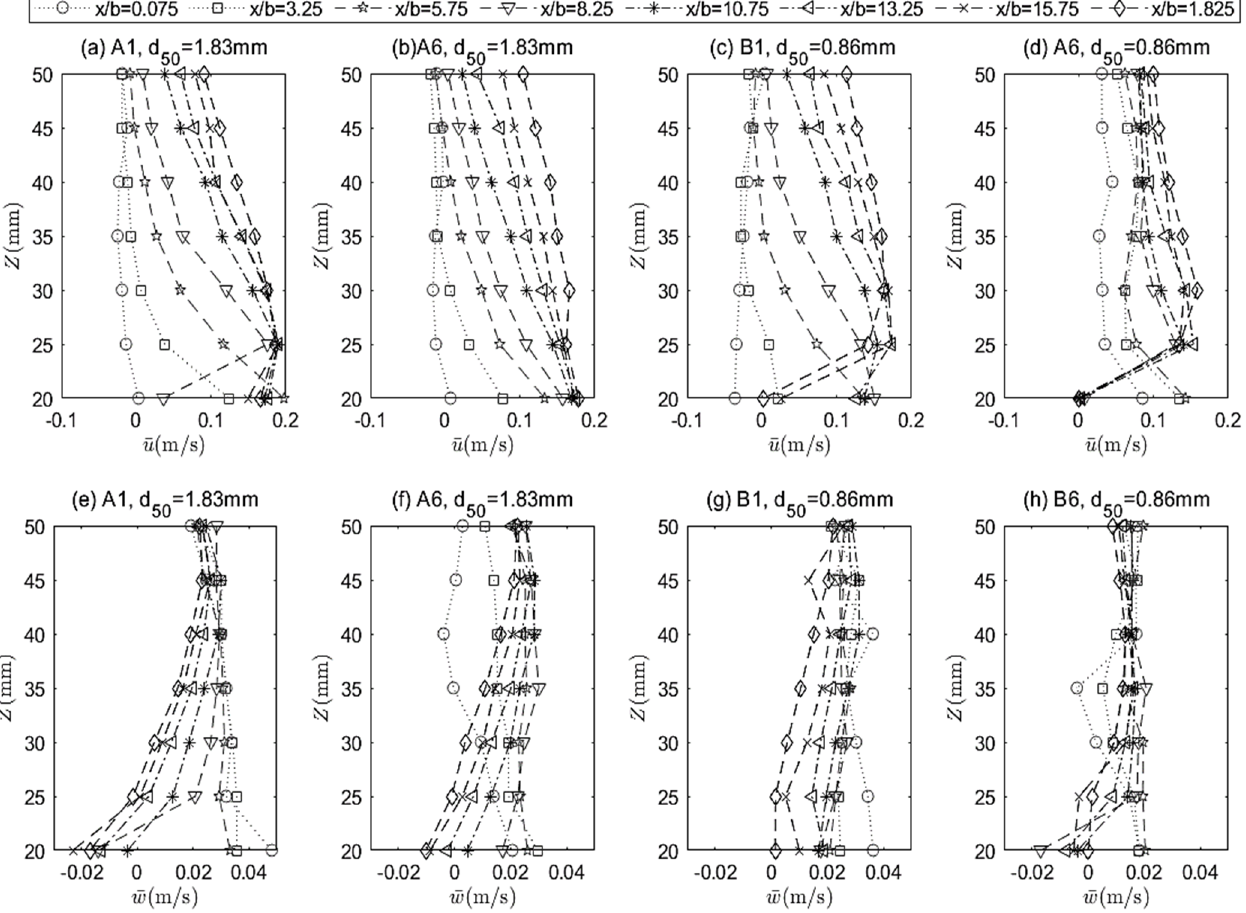
Figure 9. Profiles of the longitudinal u ( a – d ) and vertical w ( e – h ) velocity components along various longitudinal X/b distances in the pier wake for both sediment d 50 = 1.83 mm (A1 and A6) ( left ) and d 50 = 0.86 mm (B1 and B6) ( right ) for the unprotected pier (A1 and B1) and the protected pier with b c /b = 0.25 (A6 and B6).